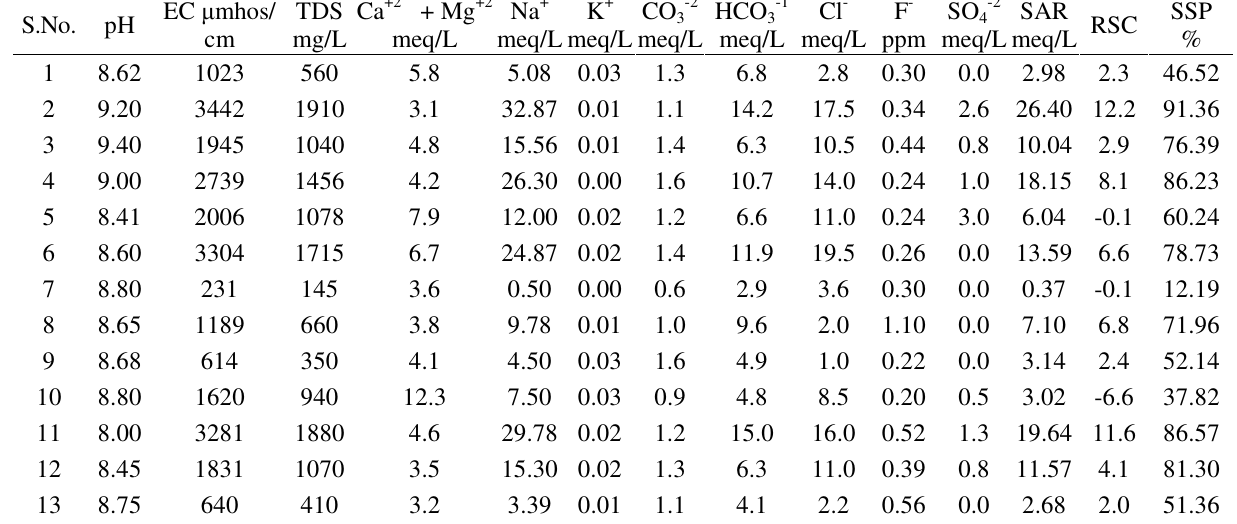
Table 1. Physico – chemical characteristics of groundwater in Bhiloda taluka (N.